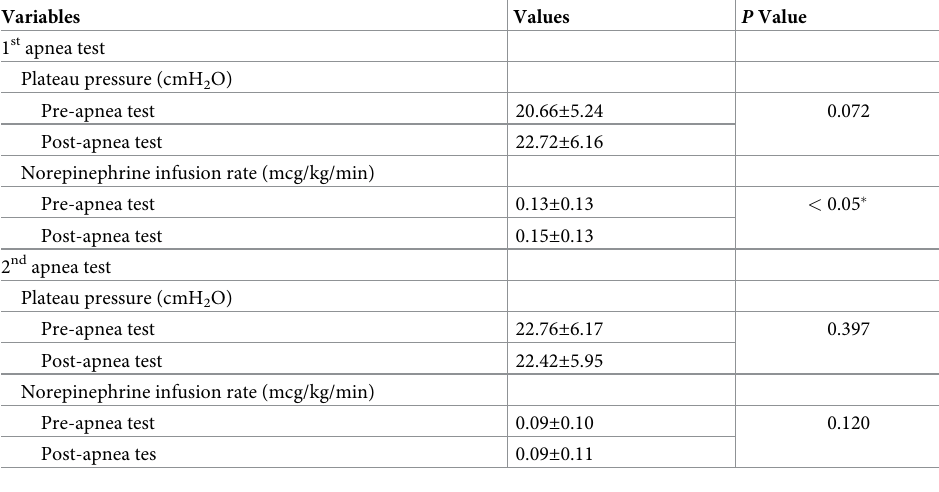
Table 3. Plateau pressure and norepinephrine infusion rate of pre- and post-apnea test.